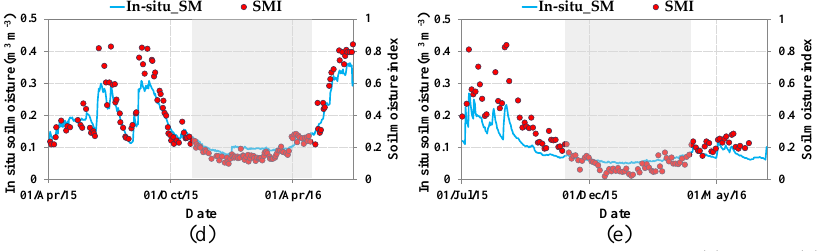
Figure 3. Temporal behavior of station-averaged soil moisture and proposed SMI calculated for (a) LWW, (b) REMEDHUS, (c) RISMA, (d) Naqu, and (e) Pali. Soil frozen days are marked by gray shadows. 00.10.20.3